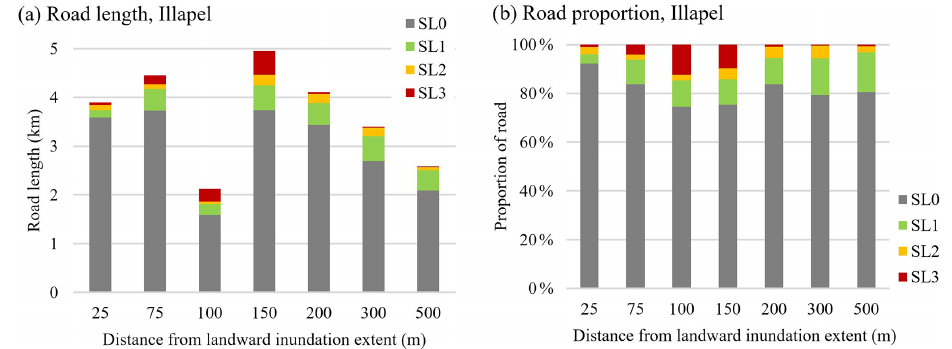
Figure 10. Total length (a) and proportion (b) of exposed roads, considering levels of service, by distance from the landward inundation extent, for the 2015 Illapel earthquake and tsunami. Note that SLU is not considered in analysis.